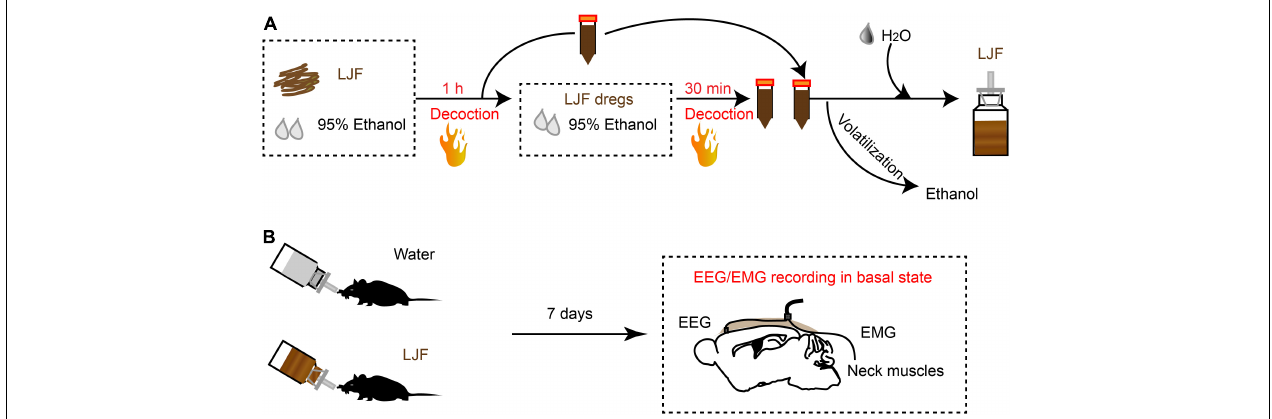
FIGURE 1 | The scheme of LJF extract preparation and EEG-EMG recordings in freely behaving mice. (A) Schematic representation shows LJF extract preparation. (B) Polysomnography recordings show wakefulness and sleep states in freely behaving mice. LJF, Lonicerae Japonicae Flos; EEG, electroencephalogram; EMG,